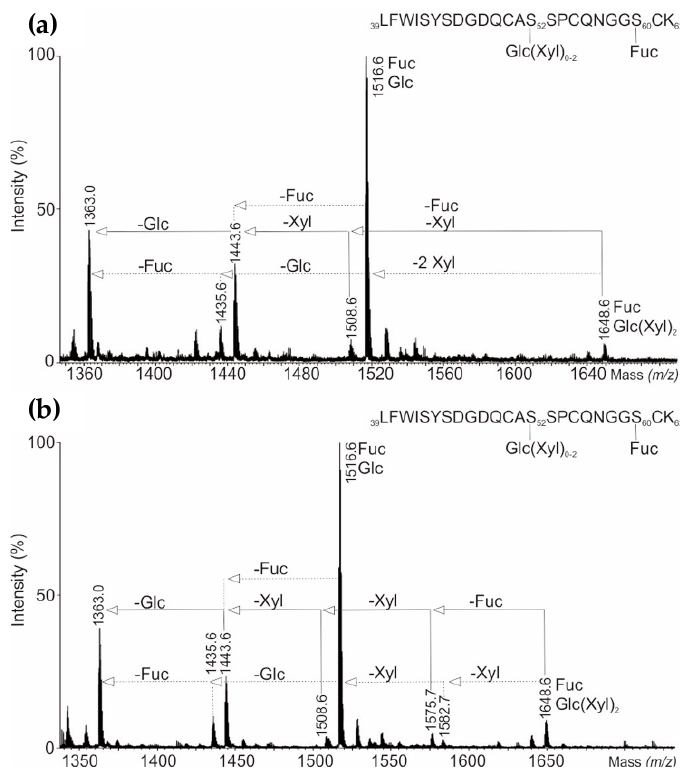
Figure 4 . ( a ) Combined precursor ESI-QTOF low-energy scan mass spectra of doubly-charged O- glycopeptides from UHPLC-QTOF-MS/MS E peptide mapping analysis showing O-glycosylation sites Ser52 and Ser60 of NovoSeven ® , and ( b ) AryoSeven™.